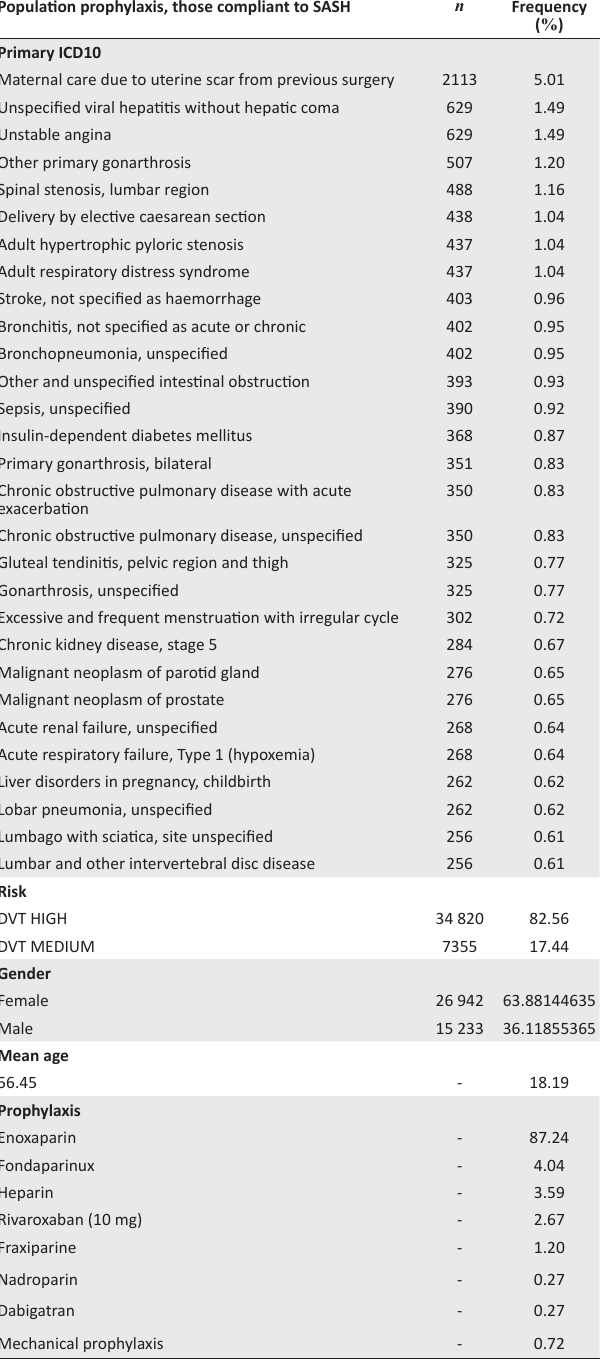
TABLE 3: Characteristics of patients who received South African Society of Thrombosis and Haemostasis compliant prophylaxis. Population prophylaxis, those compliant to SASH